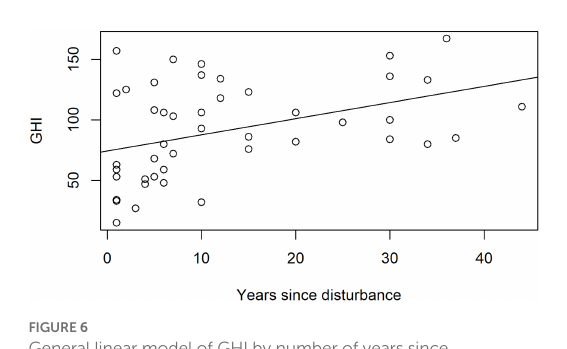
FIGURE 6 General linear model of GHI by number of years since disturbance, for 46 samples of the Nimba dataset. GHI = 74 + 1.34 × AGE, p = 0.005, R 2 = 15%.